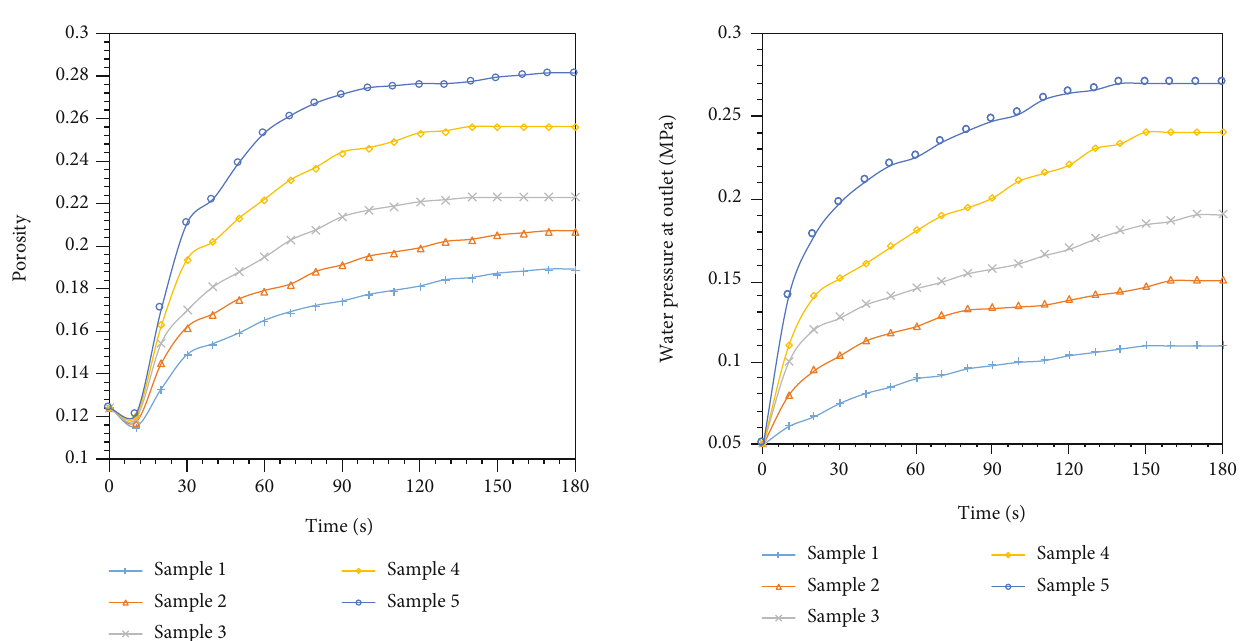
Figure 7: Evolution of sample porosity during the erosion seepage.